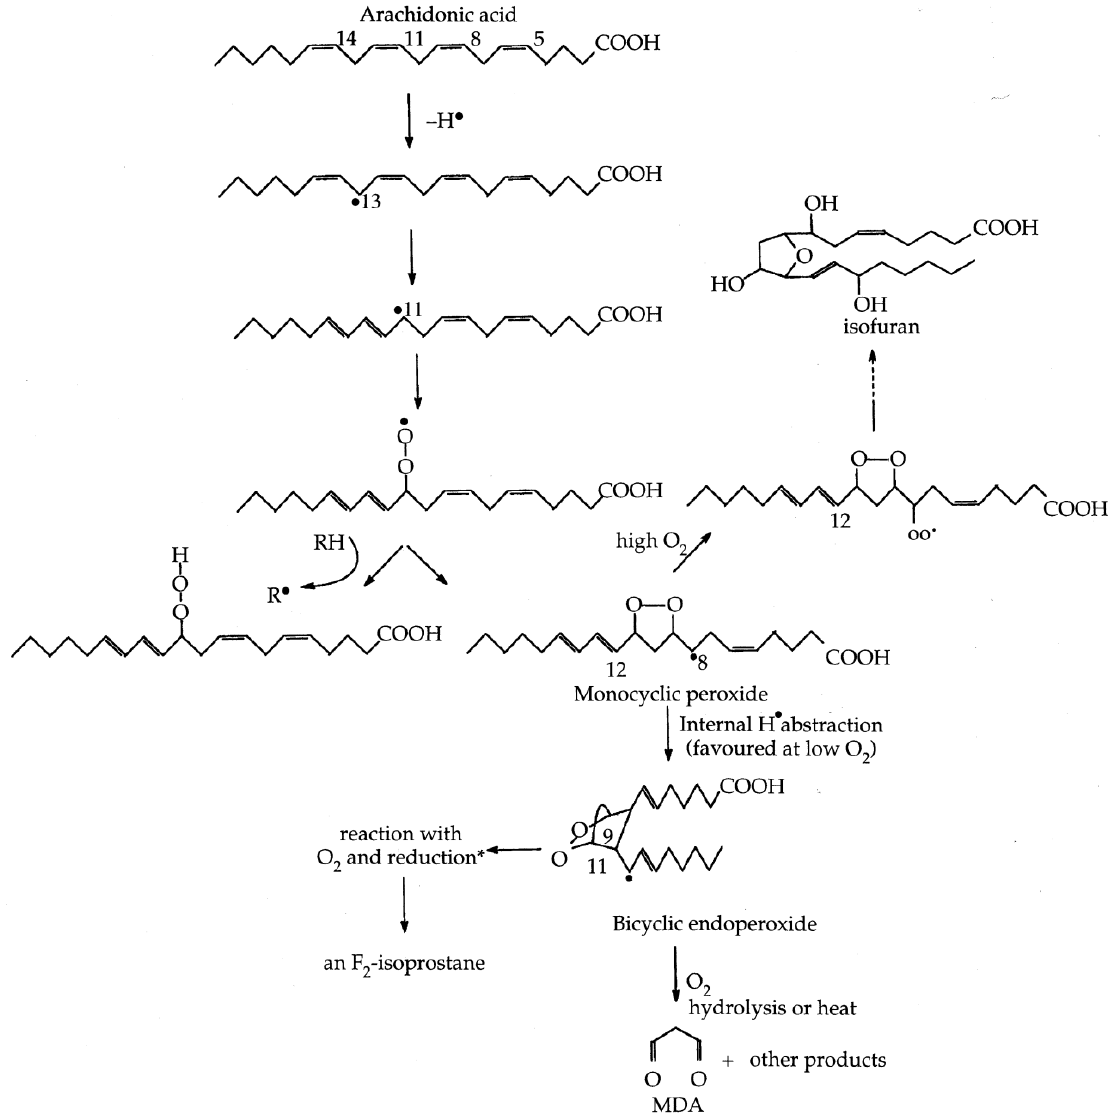
Figure 2. Formation of lipid hydroperoxides and cyclic peroxides from arachidonic